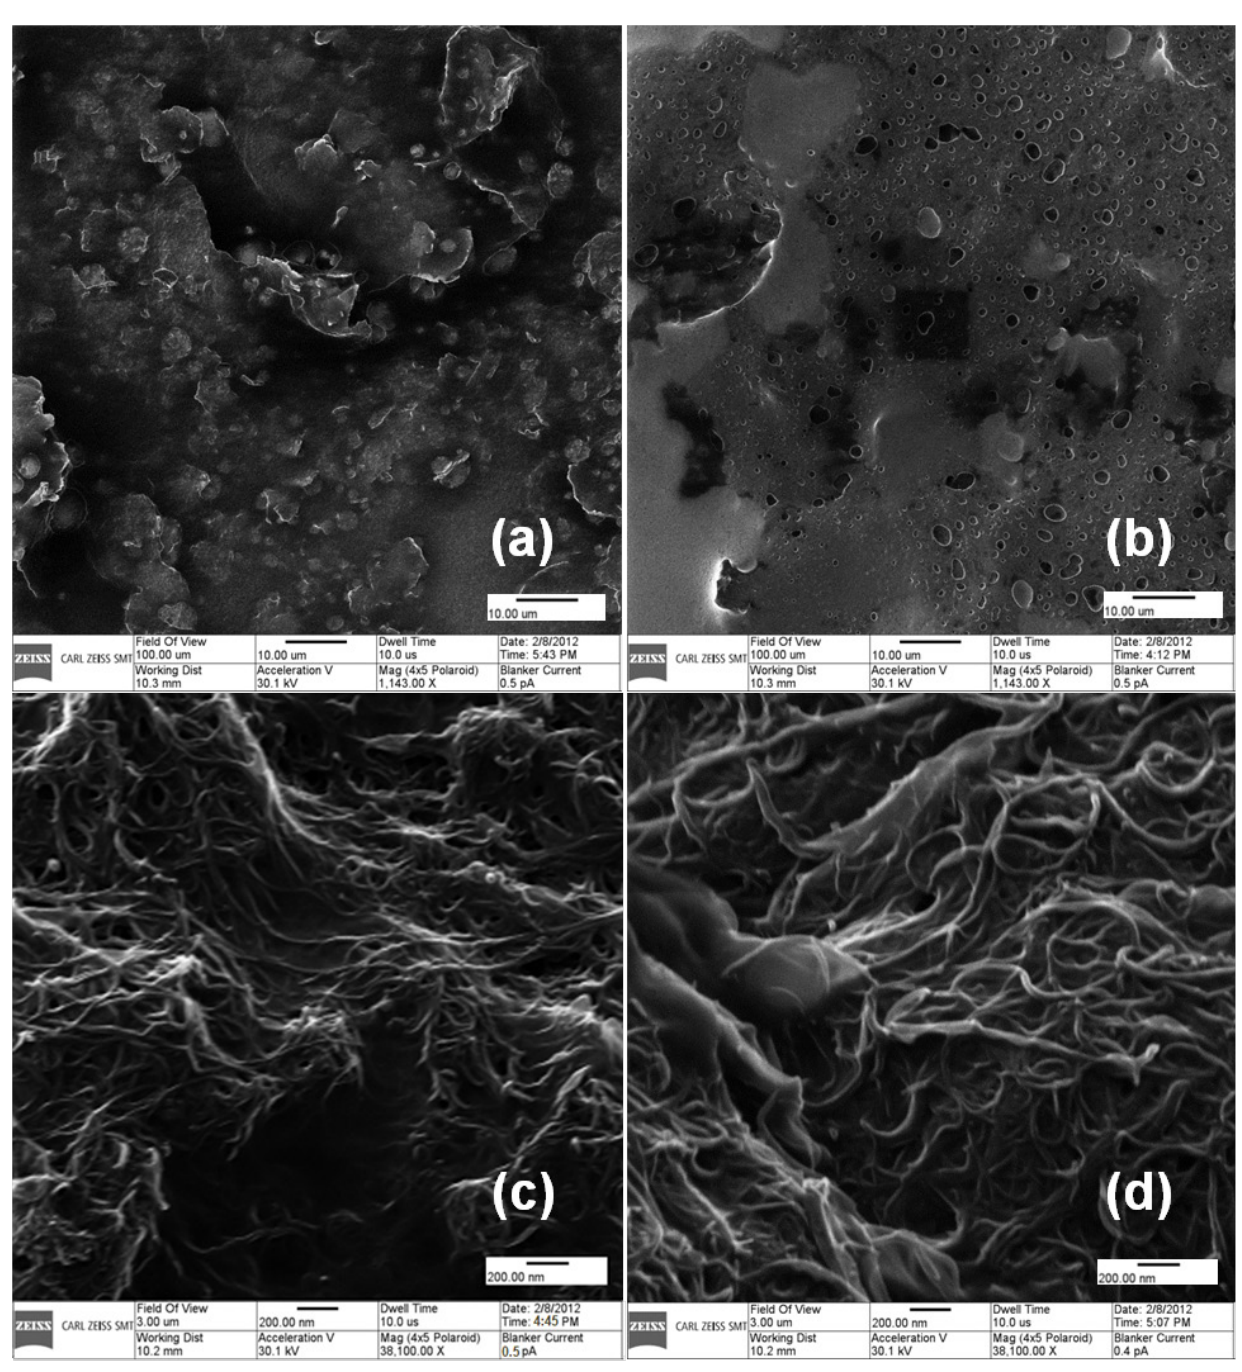
Figure 1. High resolution images of ( a ) grapheme-glucose oxidase (GOx); ( b ) Nafion/graphene-GOx; ( c ) MWCNT-GOx and ( d ) Nafion/MWCNT-GOx modified glassy carbon substrates using a helium ion microscope from Carl Zeiss, Germany.